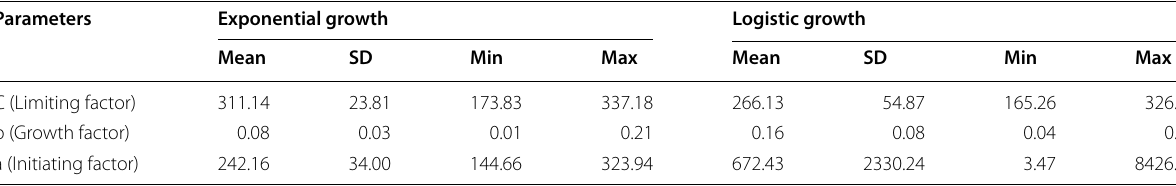
Table 4 The parameters of station growth models